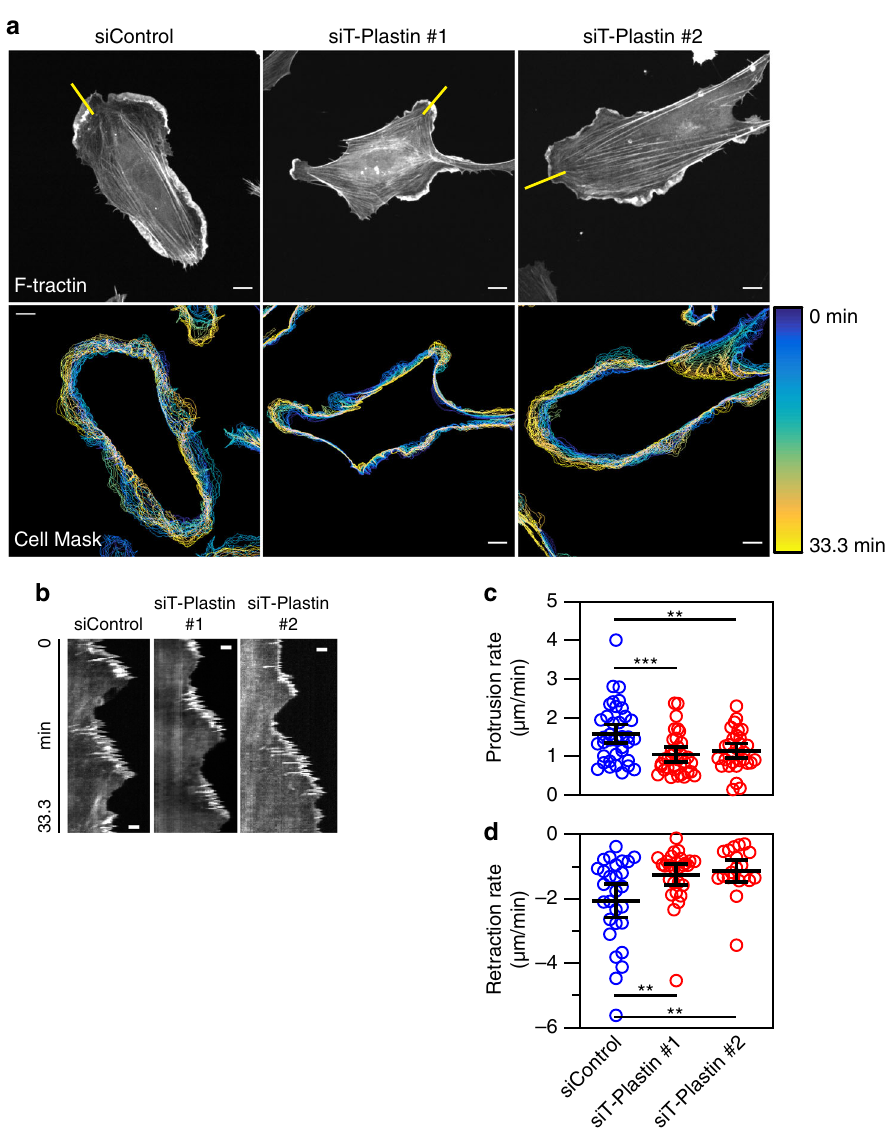
Fig. 3 T-Plastin enhances protrusion dynamics. a HUVEC expressing F-tractin-mCitrine were treated with control or T-Plastin siRNA, sparsely plated, and imaged every 10 s for ~33 min. Masks were generated of the cell edge boundaries and time-projected with each line representing a 50 s interval, the parula colormap represents the 0 min time as blue and 33.3 min time as yellow. Straight yellow lines over F-tractin images indicate regions used to generate kymographs shown in ( b ). Bars, 10 µ m. b Kymographs generated from F-tractin images shown in ( a ), bars 2.5 µ m in the x -direction. The y -direction is time with each pixel as 10 s, the entire length equaling 33.3 min. Protrusions can be seen moving outward from the cell body (toward the right) and retractions inward toward the left. c Quanti fi cation of protrusion rates generated from kymographs such as those shown in ( b ). ( n of protrusions are: siControl = 38, siT-Plastin #1 = 34, siT-Plastin #2 = 30, taken from two independent replicates). d Quanti fi cation of retraction rates generated from kymographs such as those shown in ( b ). ( n of retractions are: siControl = 28, siT-Plastin #1 = 28, siT-Plastin #2 = 20, taken from two independent replicates). Bars represent means, error bars represent 95% CI, each siRNA targeting T-Plastin was compared to siControl using a one-way ANOVA with Dunnett ’ s multiple comparison test ** P < 0.01, *** P <